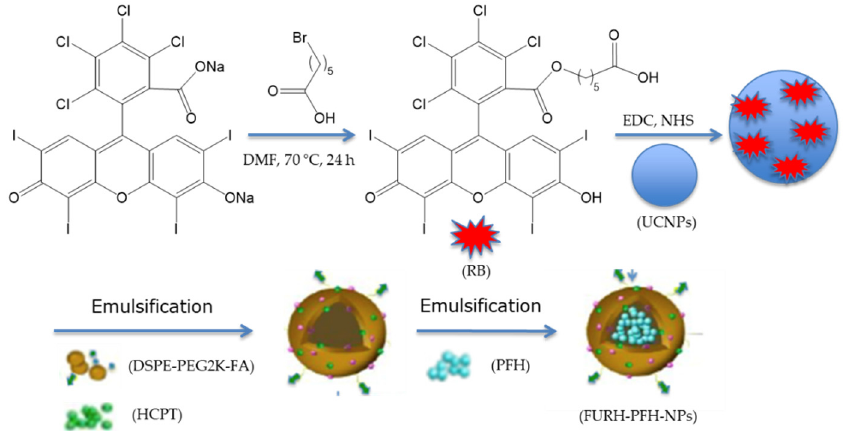
Figure 16. Preparation of FURH-PFH-NPs. Adapted from Wang et al. [39].